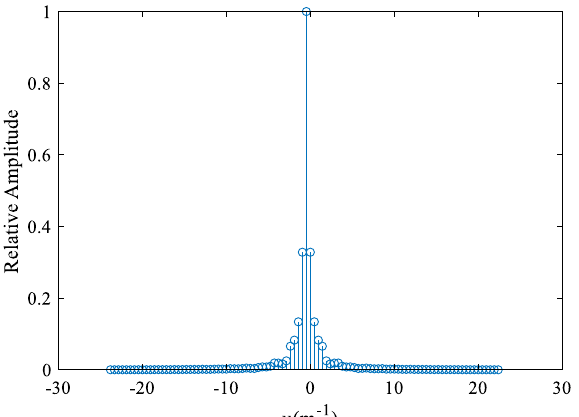
Fig. 15 One-dimensional amplitude spectrum of terrain deformation shape #1 (taking y example)